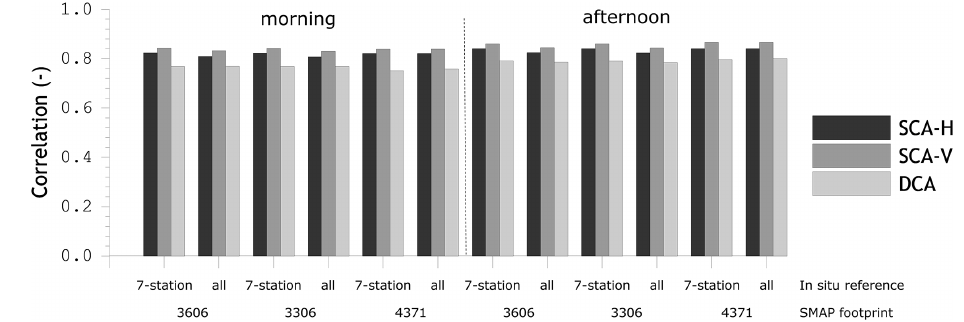
Figure 9. Pearson product moment correlation coefficient computed between SMAP soil moisture and in situ references.